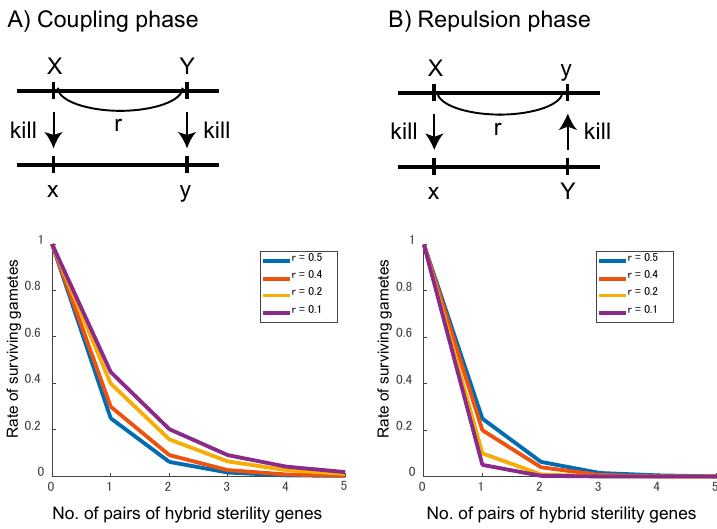
Figure 4. The effect of number, linkage and phase of hybrid sterility loci. In the locus X gametes with the allele “x” are preferentially abort, while gametes with the allele “X” survive. In the locus Y, gametes with the allele “y” are preferentially abort, while gametes with the allele “Y” survive. Loci X and Y link with a recombination frequency of “r”. The expected frequency of surviving gametes (no. of surviving gametes/no. of all gametes) against no. of pairs of sterility loci are plotted. The recombination frequency “r” varies from 0.1 to 0.5. ( A ) Coupling phase. ( B ) Repulsion phase.